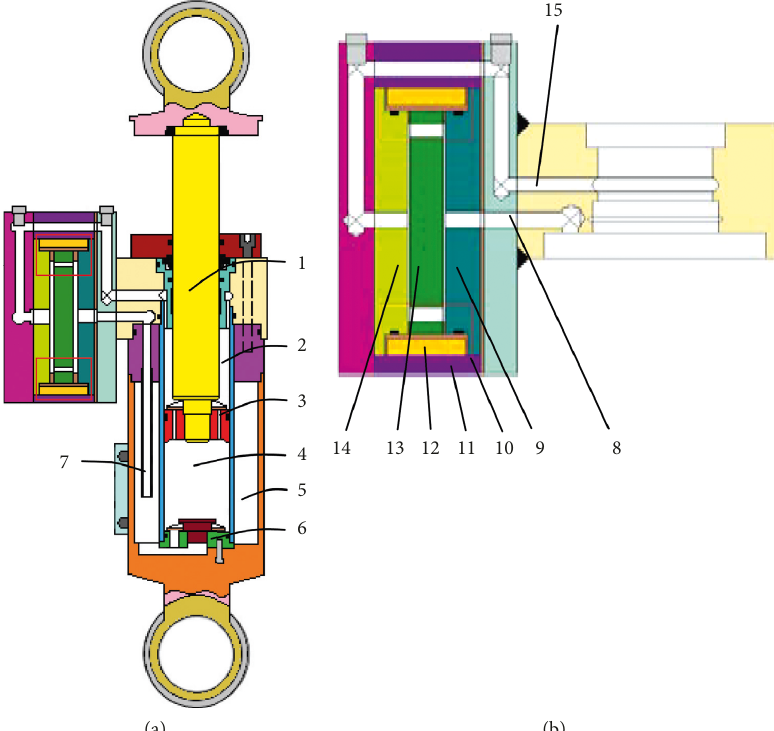
Figure 36: Schematic view of the twin-tube and bypass MR damper based on radial flow mode:1, piston rod; 2, rebound chamber; 3, piston valve; 4, compression chamber; 5, oil reservoir; 6, foot valve; 7, connecting tube; 8, outlet; 9, first magnetic guide plate; 10, magnetic flux; 11, magnetic guide cylinder; 12, coil; 13, core; 14, second magnetic guide plate; 15, inlet [28,